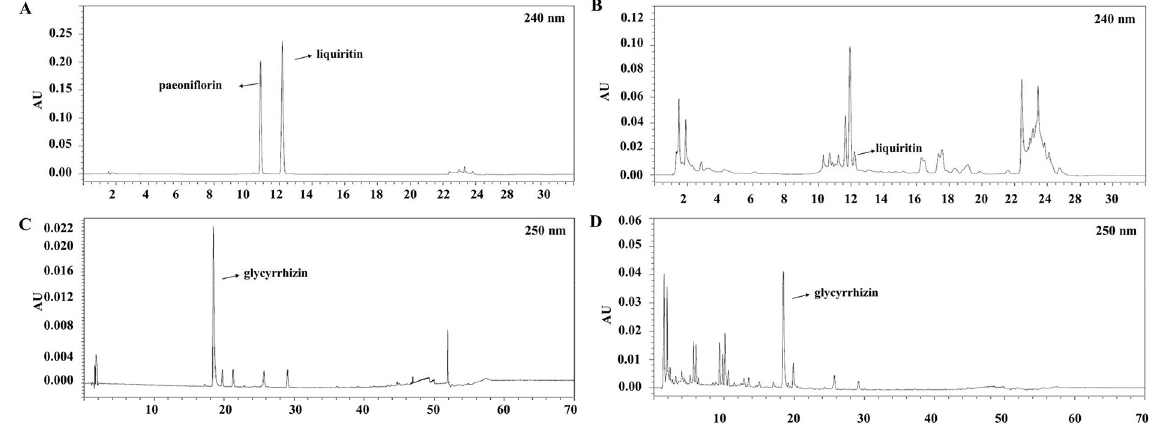
Fig 1. HPLC results of macmoondongtang . (A) standard- liquiritin and paeoniflorin; (B) macmoondongtang , 50 mg/mL, (C) standard- glycyrrhizin; (D) macmoondongtang, 25 mg/mL.